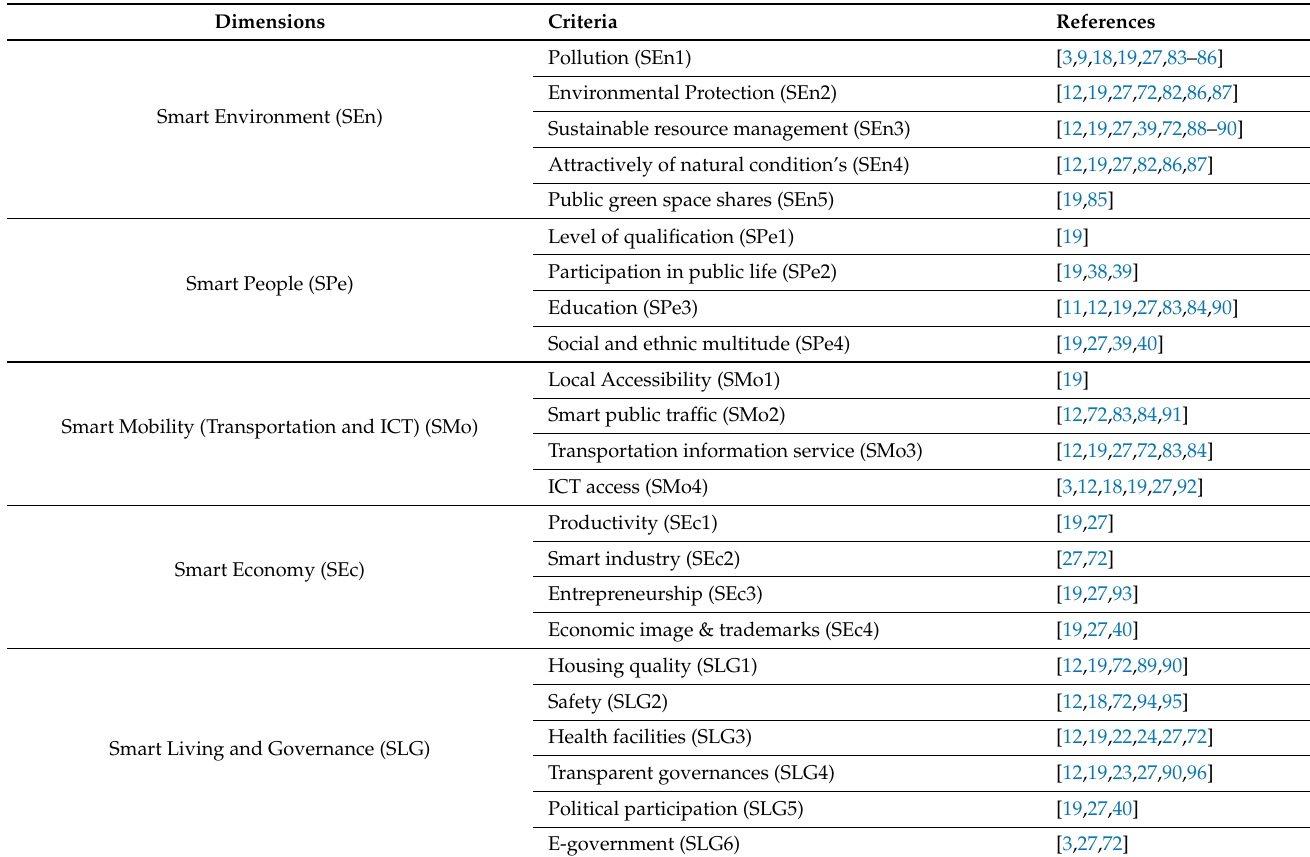
Table 5. The principal dimensions / criteria reported in literature.